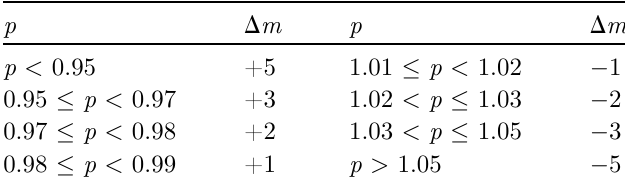
Table 3. Adjustment rules of the position of control